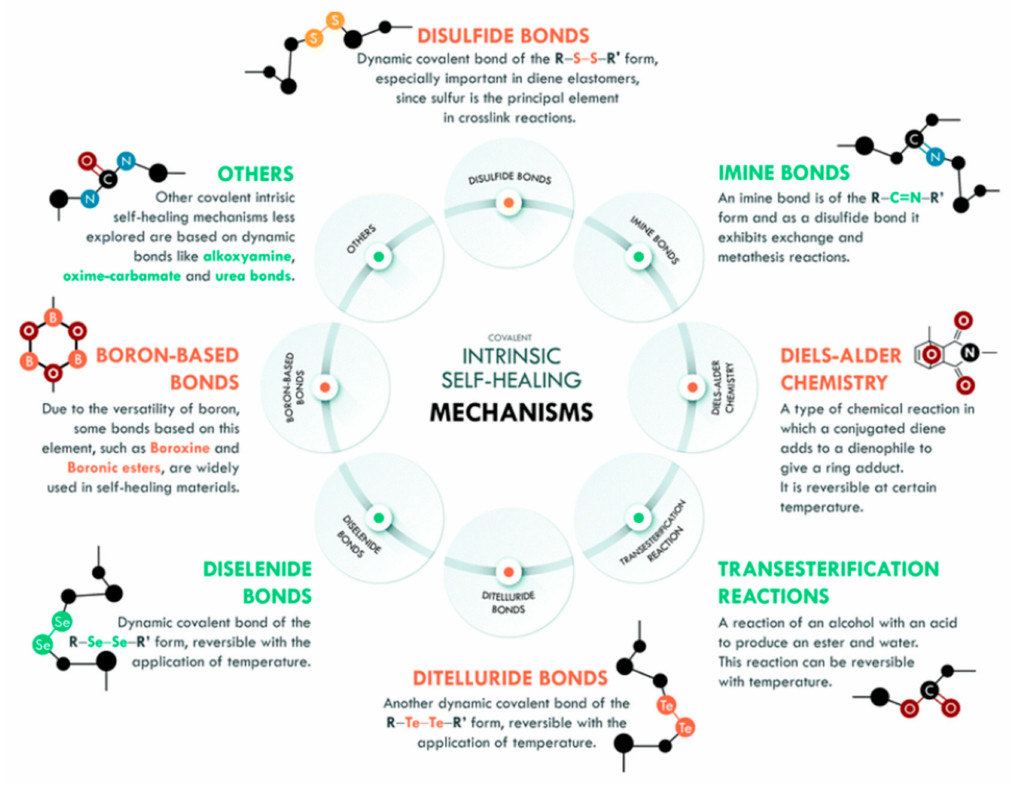
Figure 3. Covalent intrinsic mechanism obtained from the authors of